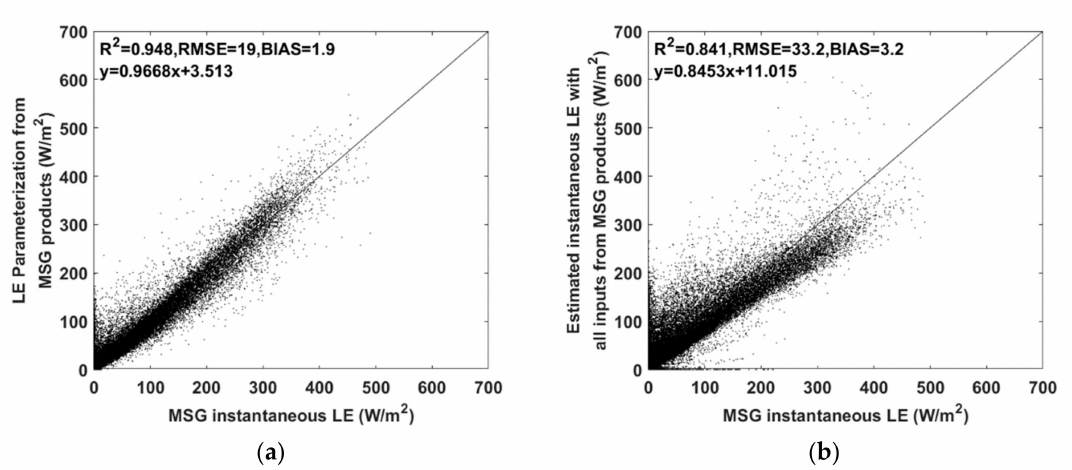
Figure 10. Evaluation of: ( a ) LE parameterization by MSG ET (MET) product; and ( b ) estimated instantaneous LE with all inputs from MSG